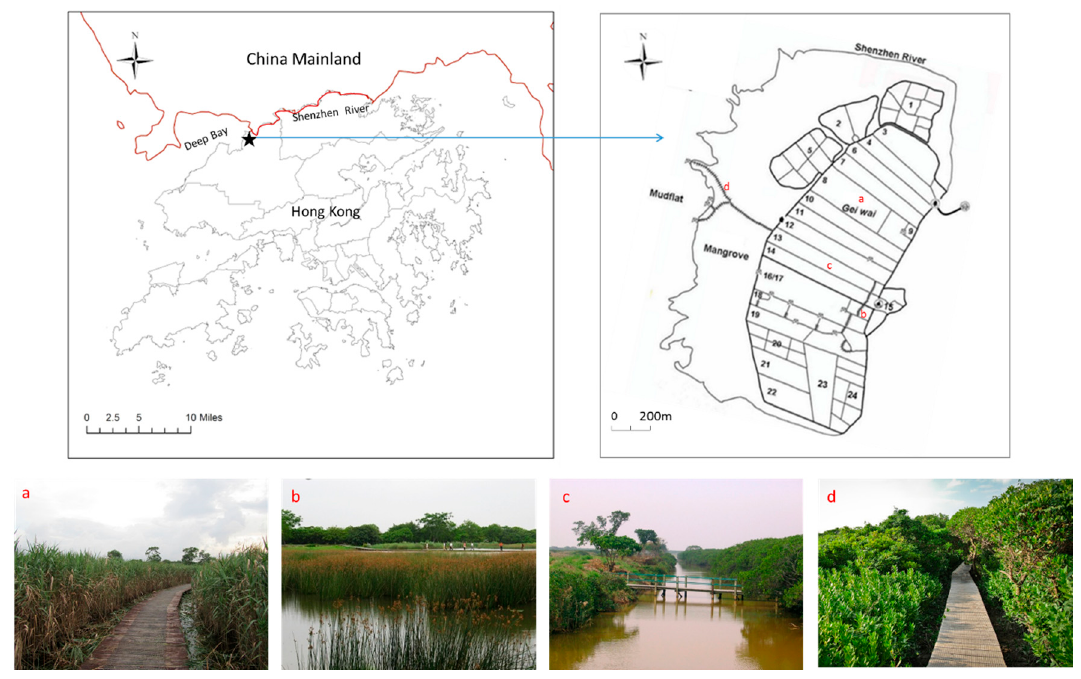
Figure 1. Locations of the five soil sampling sites: ( a ) Reedbed; ( b ) Freshwater pond; ( c ) Gei Wai forest and Gei Wai water channel; and ( d ) Mangrove.